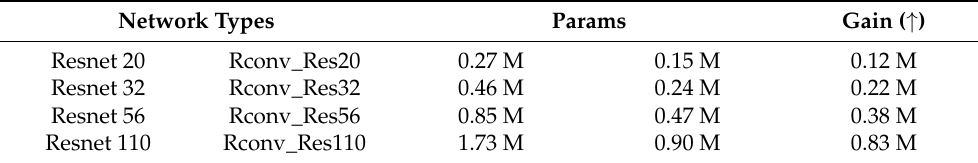
Table 4. The ablation experiment results of different student sub-networks in the CKD